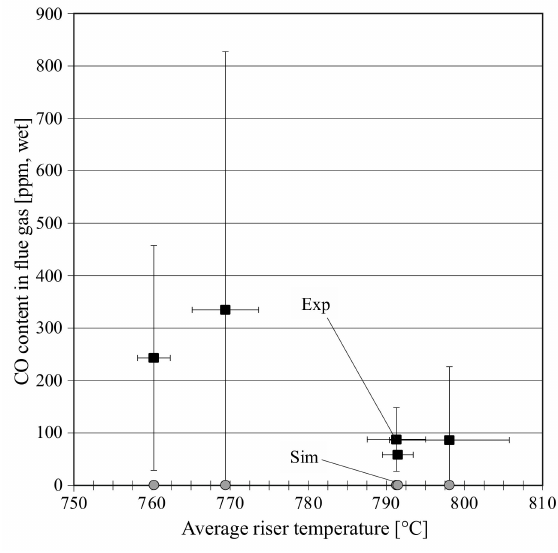
Figure 11. CO content in flue gas for varying riser